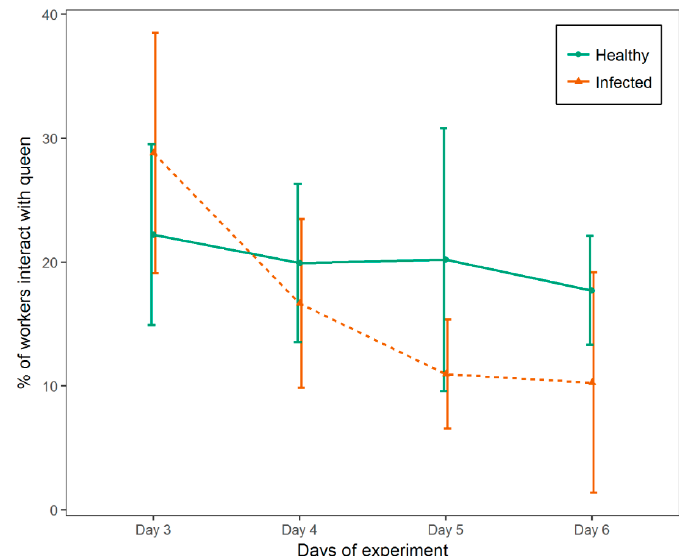
Figure 6. Percentage of honey bee worker attending the queen as a function of the duration of infection. The attendance behavior of infected and control workers changed from a higher proportion of infected workers attending to the queen than healthy workers on experimental Day 3 to the opposite trend on 3 subsequent days, which coincide with the highest mortality rate induced by IAPV.